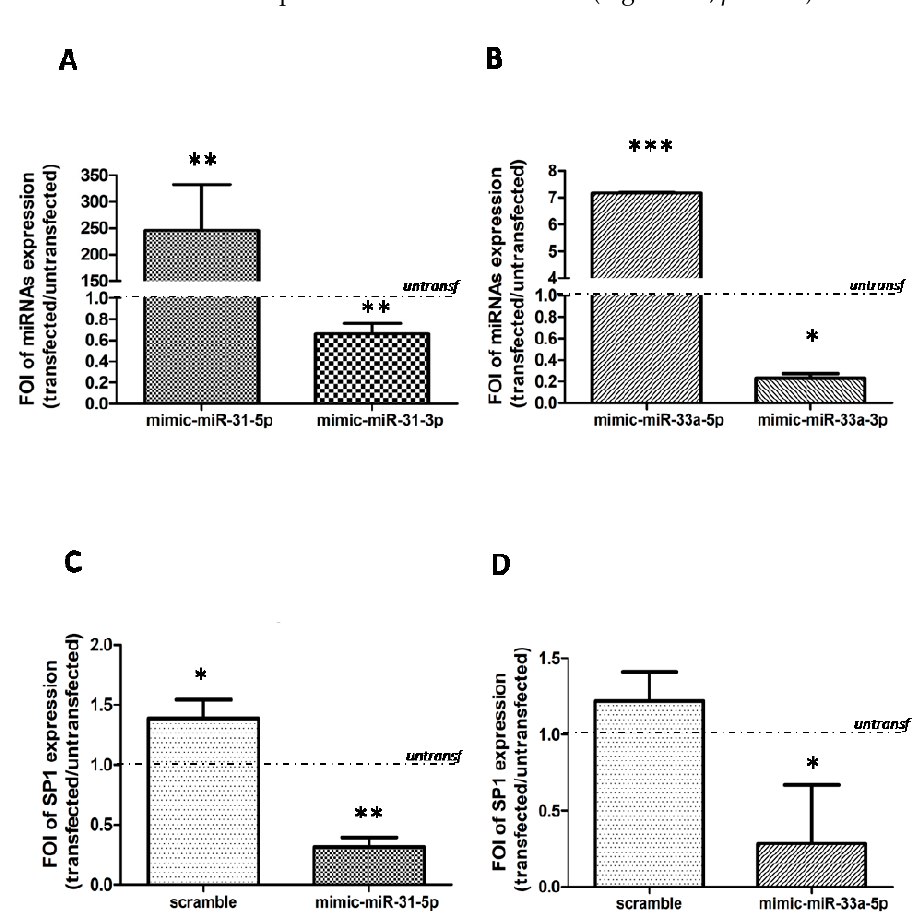
Figure 4. Study of SP1 gene expression modulation by gain and loss of function assays. Osteoblasts (OB) and chondrocytes (CH) isolated by mild OA patients (mild OA) after 24 h of transfection with: miR-31-5p mimic and miR-31-3p mimic for OB cells, with miR-33a-5p mimic and miR-33a-3p mimic for CH cells and relatives scrambles. Cells were analyzed for the gene expression modulation of SP1 by qRT-PCR analysis. ( A ) The efficiency of miR-31-5p mimic and miR-31-3p mimic and relatives scrambles transfection were evaluated in transfected mild OA-derived OB versus untransfected ones. ( B ) The efficiency of miR-33a-5p mimic and miR-33a-3p and relatives scrambles transfection were evaluated in transfected mild OA-derived CH versus untransfected ones. SP1 gene expression evaluated in ( C ) OB isolated from mild OA patients transfected with mimic-31-5p and negative scramble, in ( D ) CH isolated from mild OA patients transfected with mimic-33a-5p and negative scramble. Quantitative RT-PCR data are expressed as fold of change (FOI) in miRNAs or gene expression (2 − ∆∆ Ct ) occurred in transfected mild OA isolated cells vs untransfected ones. Data reported were analysed by Student t test: *, p < 0.05, **, p < 0.005, ***, p < 0.0005 between experimental group and represented as mean ± SD ( n = 4).